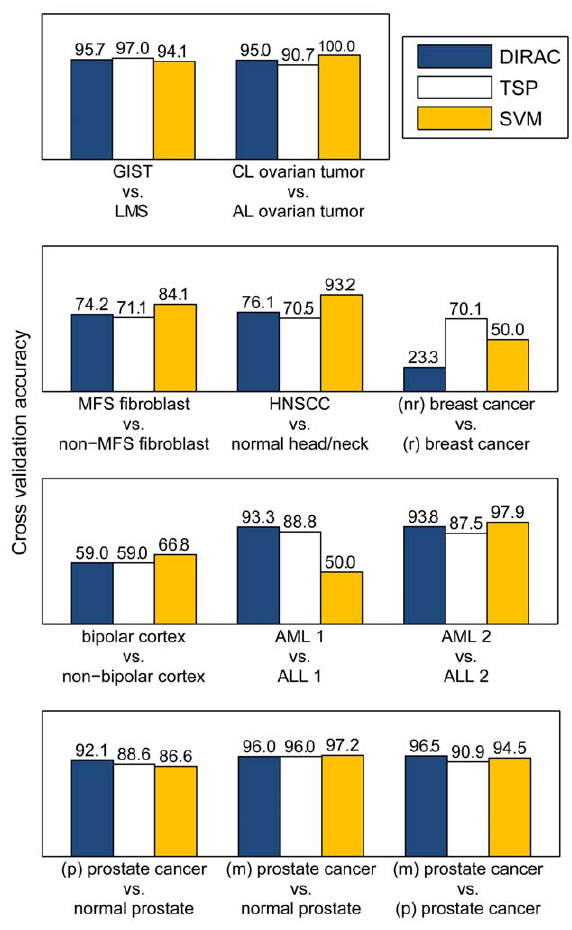
Figure 8. Classification with DIRAC compared to other